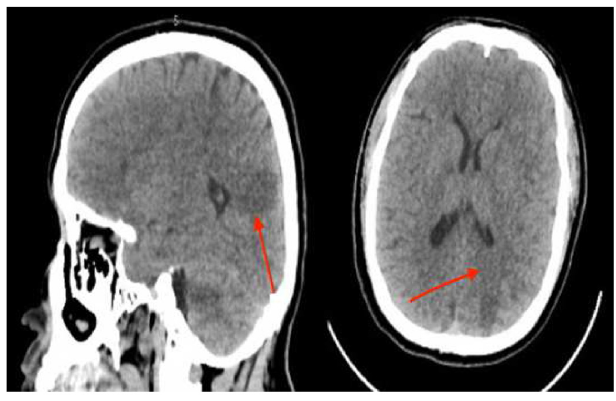
Figure 1. contrast-enhanced computed tomography (CT) scan showed embolic cerebral infraction consisting in multiple supratentorial regions of hypodensity in a vascular distribution occurring in the white